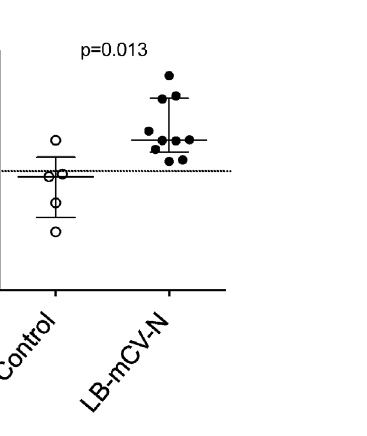
Figure 3. IL-1RA concentrations from cervical vaginal lavage (CVL) samples of control or LB-mCV-N colonized macaques during the SHIV challenge experiment. IL-1RA levels are reported as the net change in cytokine with the baseline (pre-challenge) values subtracted. IL-1RA was significantly higher in LB-mCV-N colonized macaques during challenge, p=0.013. Note: SHIV transmission occurred at the first challenge in four animals (three controls and one LB-mCV-N), thus there were insufficient values available for baseline subtraction, and these animals were excluded from the analysis. One LB-mCV-N animal was missing a pre-challenge sample and was also